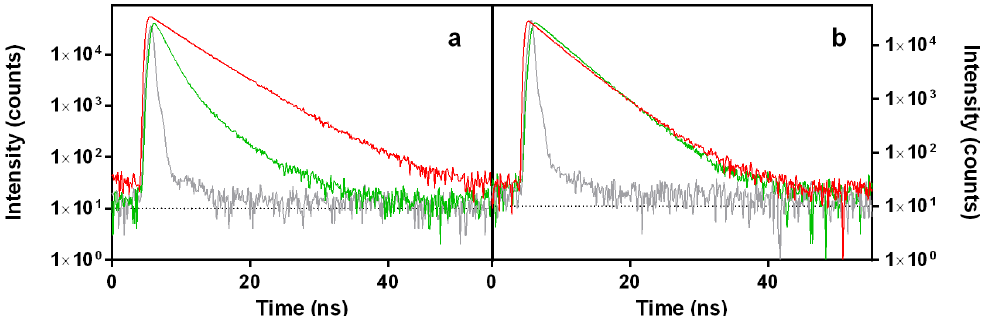
Figure 3. Time-resolved fluorescence (TRF) decays for DOXO (green) and PhA (red) in EtOH ( a ) and D 2 O ( b ). Grey traces represent the instrument response function. DOXO was excited at 504 nm and PhA at 654 nm. Observation wavelengths were 660 nm and 710 nm, respectively.